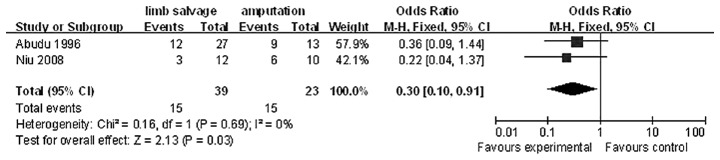
Forest plot of comparison: metastatic occurrence in patients receiving limb salvage vs. amputation for the treatment of osteosarcoma in patients with pathological fracture.